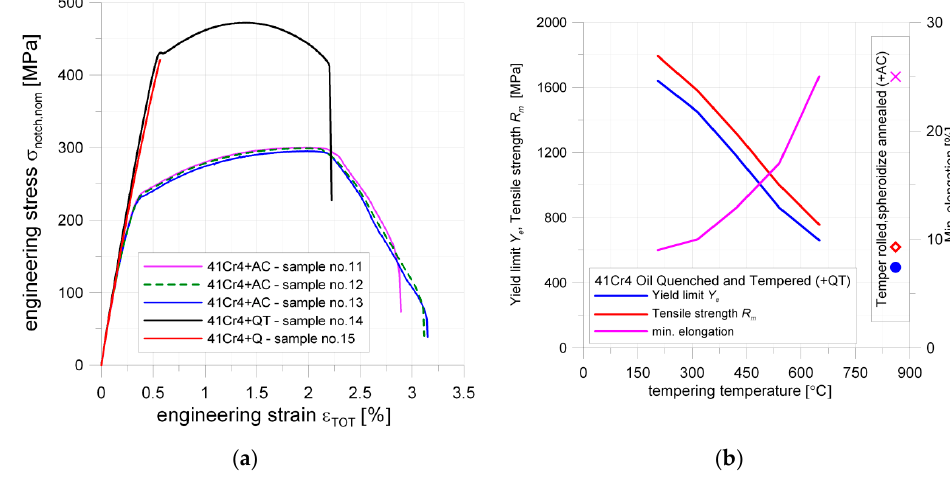
Figure 18. Steel 41Cr4: ( a ) Stress–strain curves for specimens made of 41Cr4 with square hole with fillet radius R2 (AC, spheroidized annealed; QT, quenched and tempered; Q, only hardened); and ( b ) minimal mechanical properties of 41Cr4 steel after heat-treatment.